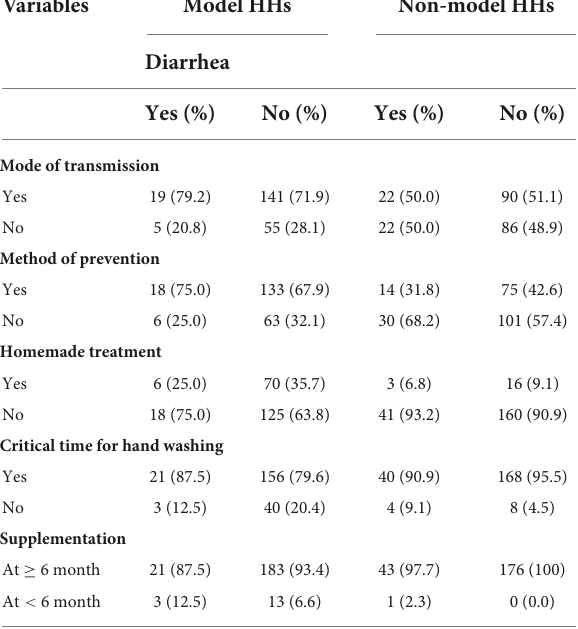
TABLE 3 Knowledge and behavioral factors of respondents in Jawi district, Awi Zone, southwest Ethiopia,